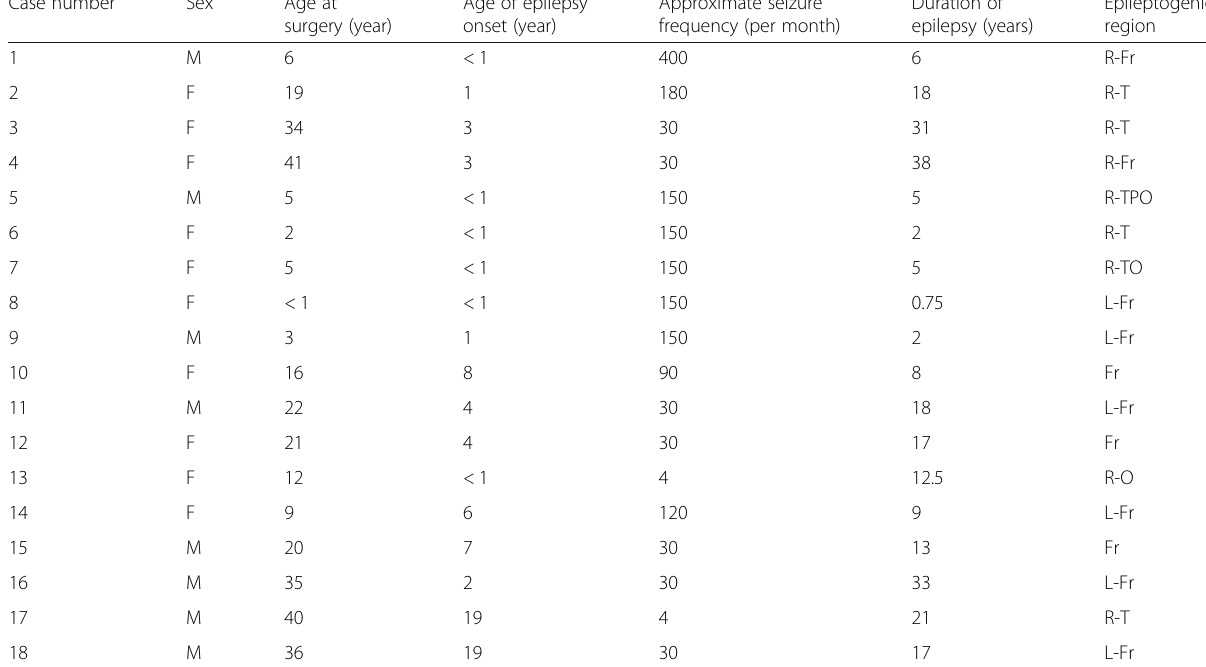
Table 2 Clinical features of patients with FCD IIb in the present cohort Case